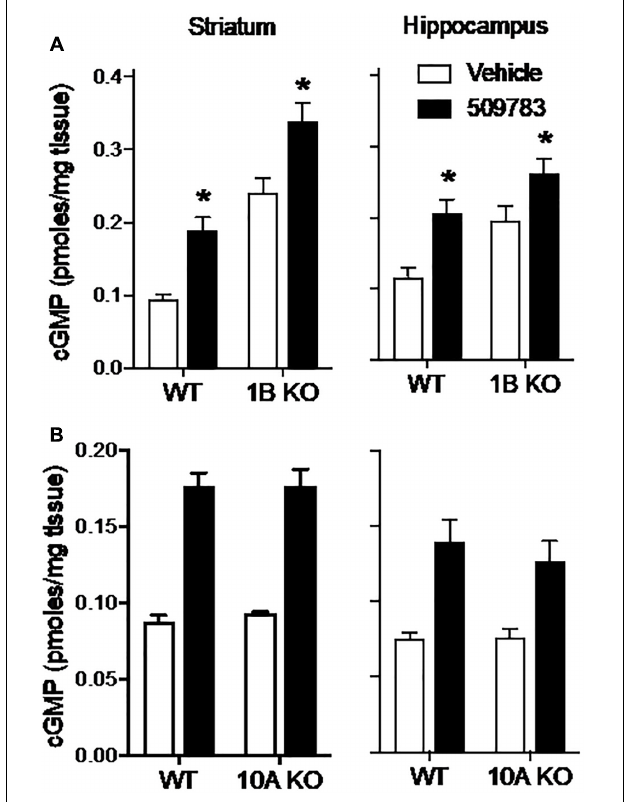
FIGURE 6 | Genetic deletion of PDE1B or PDE10A did not effect increases in cGMP induced by pharmacological inhibition of PDE9A. PF-509783, administered 30 min prior to sacrifice, significantly elevated striatal (Str) and hippocampal (Hip) cGMP content in PDE1B (A) and PDE10A (B) knockout mice. Results were analyzed by two-way ANOVA (PDE9A inhibitor X gene status) in each brain region followed by post hoc tests of the effect of the PDE9A inhibitor in each strain, corrected for multiple comparisons. PDE1B knock out (A) . In the striatum, there was a significant main effect of PF-509783 [ F (1, 16) = 28.04, P < 0.0001], and a main effect of PDE1B knock out [ F (1, 16) = 66.73, P < 0.0001] but not an interaction [ F (1, 16) = 0.005939, P = 0.9395]. In the hippocampus, there was a significant main effect of PF-509783 [ F (1, 15) = 19.58, P = 0.0005], and a main effect of strain [ F (1, 15) = 14.71, P = 0.0016] but not an interaction [ F (1, 15) = 0.4524, P = 0.5114]. Subsequent post hoc tests indicated that the cGMP